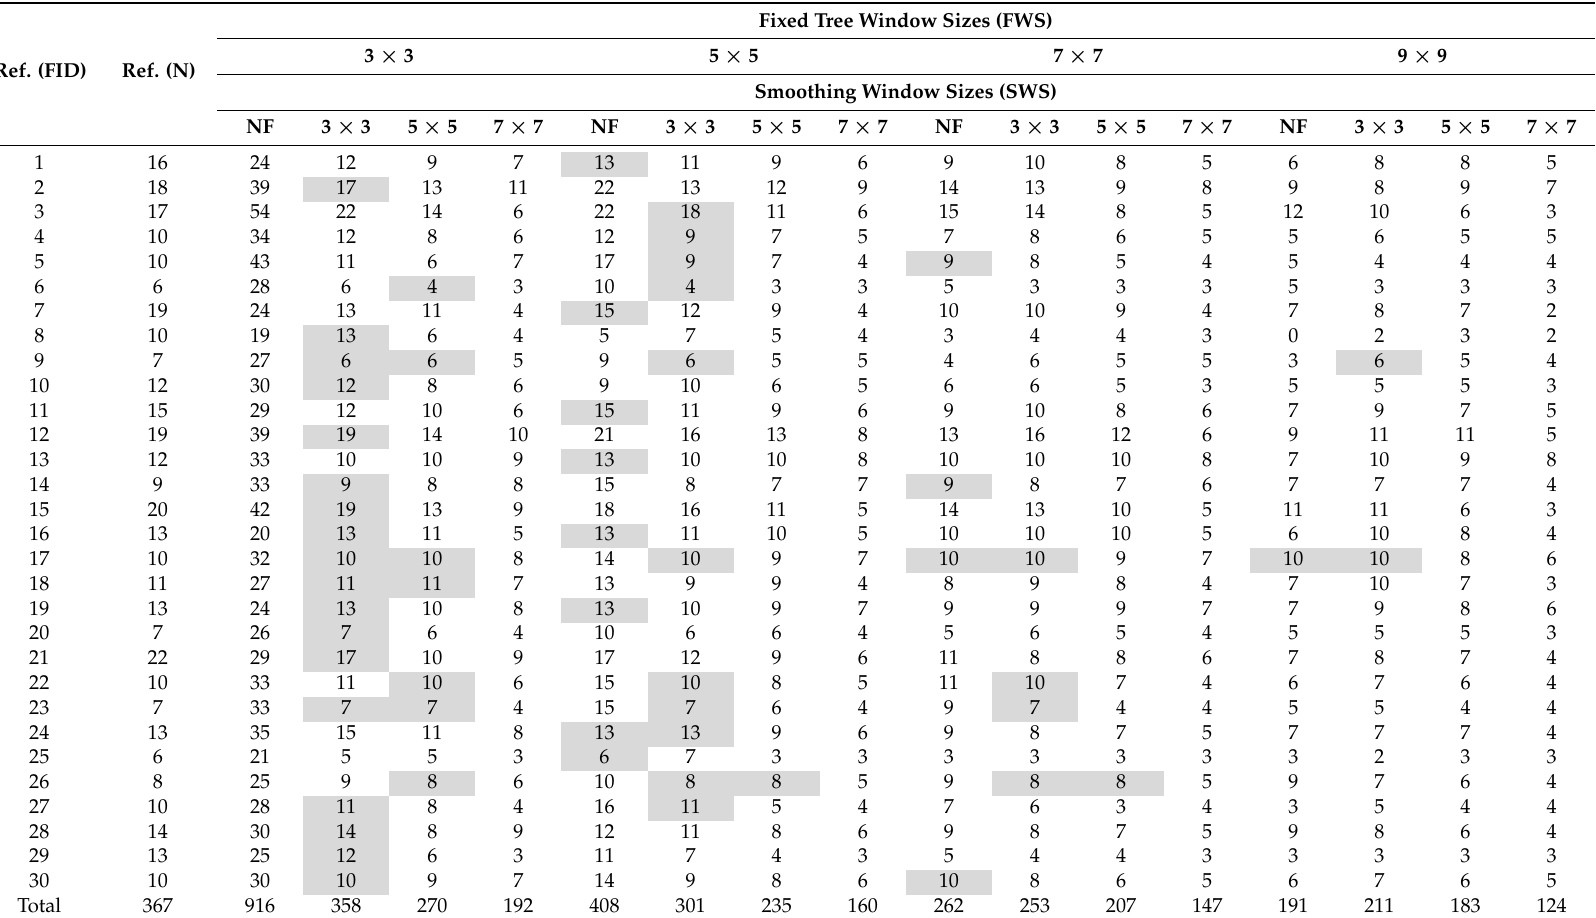
Table 2. The highlighted grey color represents the best results, which were determined by comparing the number of trees detected (NTD) to the field-based tree inventory number (N). The closest values of NTD compared with N were selected as the best results.